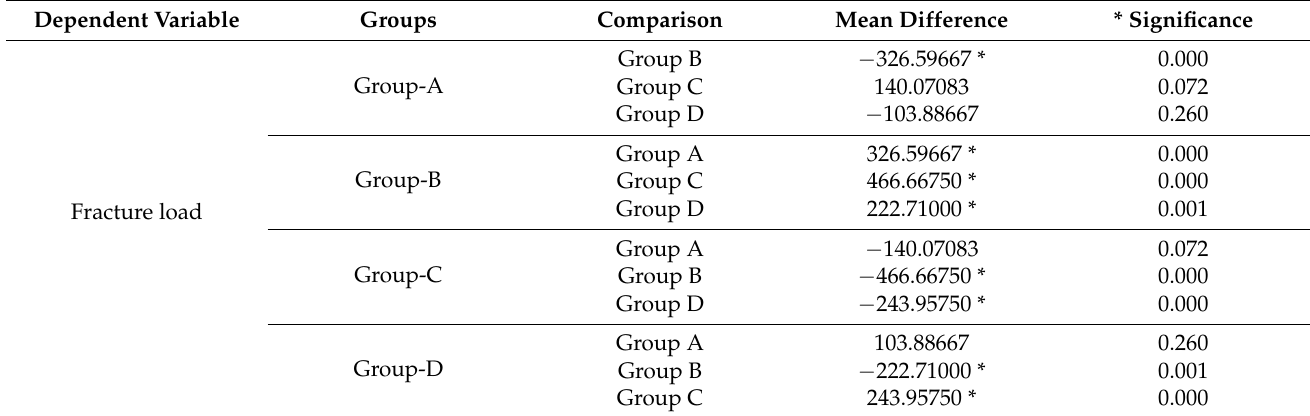
Table 2. Multiple Comparisons and mean differences of the fracture load between the test groups by Post-Hoc Tukey test. Dependent Variable Groups Comparison Mean Difference *